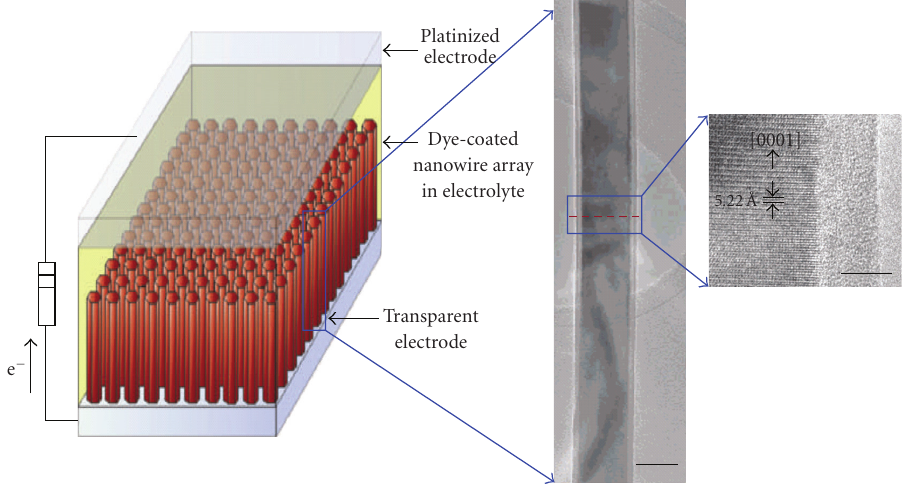
Figure 14: NW film-based DSC (from